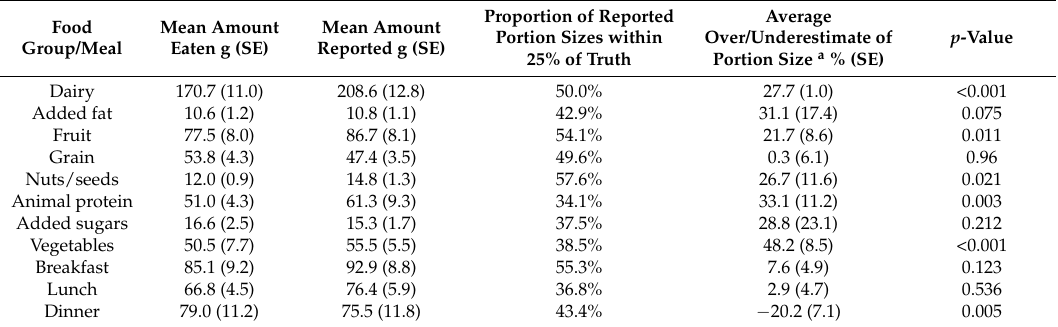
Table 4. Mean true and reported portion sizes, proportion of reported within 25% of truth, and results of regression analysis of reported percentage portion size over- or underestimate of actual portion size consumed, by food group and meal type ( n = 445